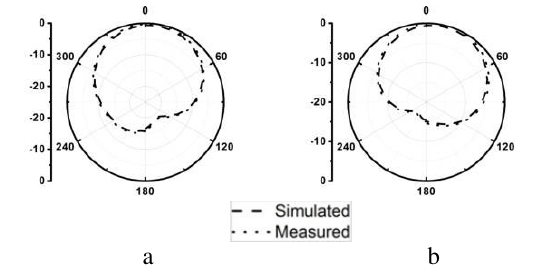
11: Simulated and measured radiation characteristics of the proposed antenna at 2.4 GHz a E